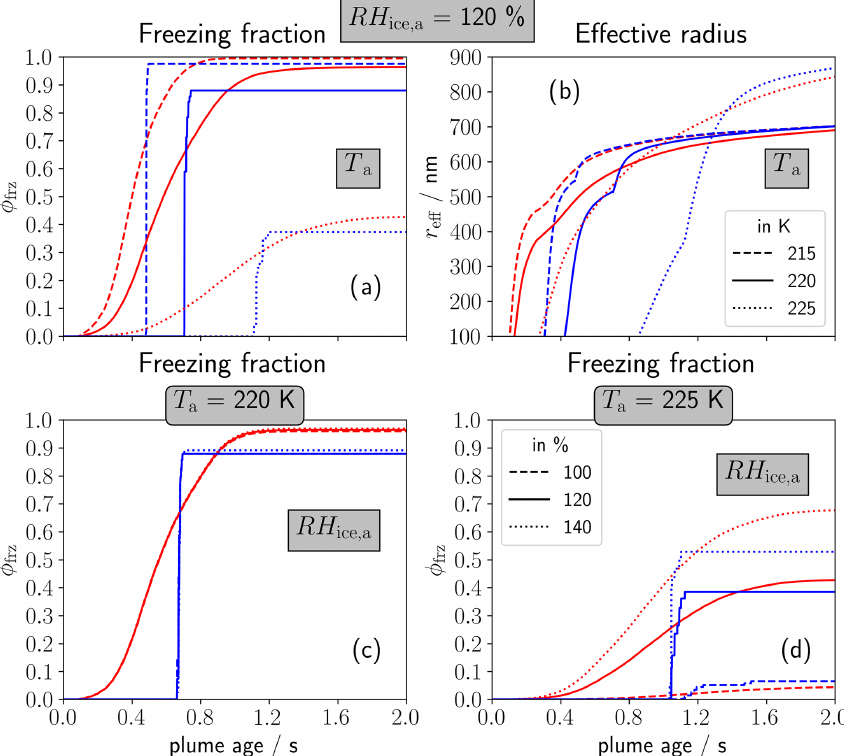
Figure 4. Temporal evolution of the freezing fraction of soot particles φ frz (a, c, d) and effective radius r eff (b) for a variation of ambient temperature T a (a, b) and RH ice,a (c, d) according to the inserted legends in the right column. The variation of RH ice,a is shown for two different T a values (see panel titles). The red lines show the ensemble mean and the blue lines the average traj